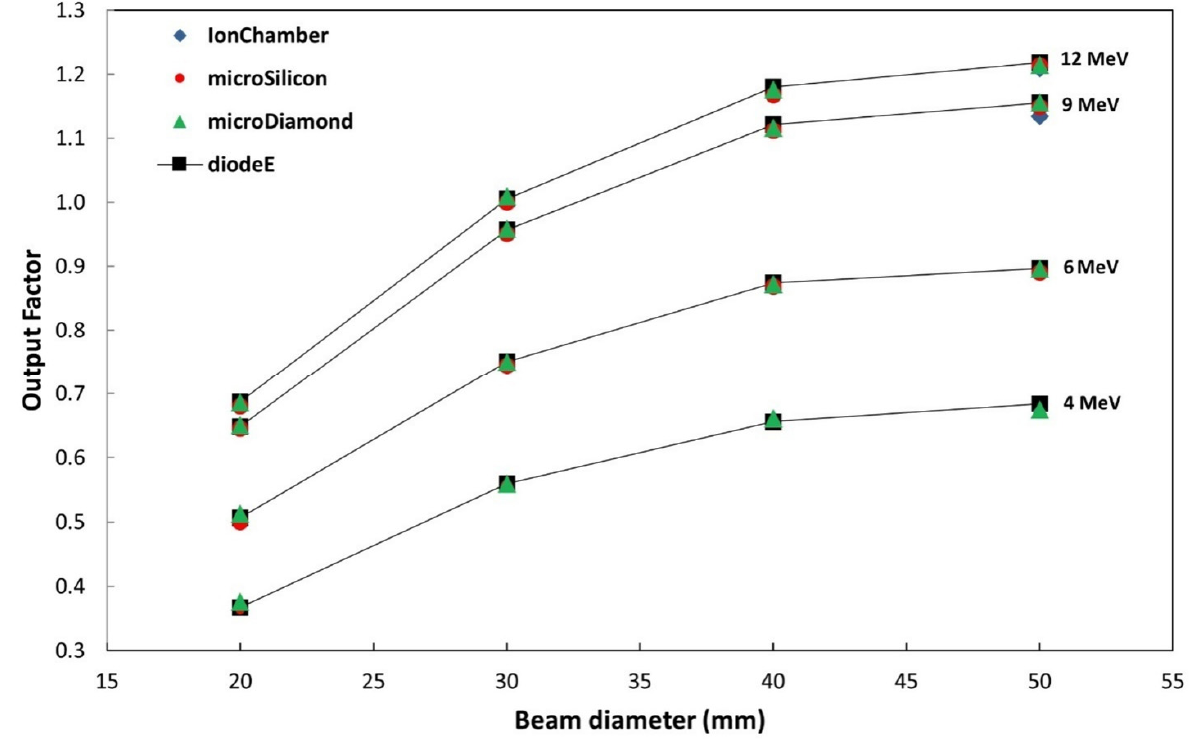
Figure 4. Output factor values, measured by all dosimeters, for all aperture diameters and beam energies. Measurement uncertainties were within the sizes of point indicators. Table 5. OF values measured for all beam energies with all the dosimeters for the 50 mm diameter